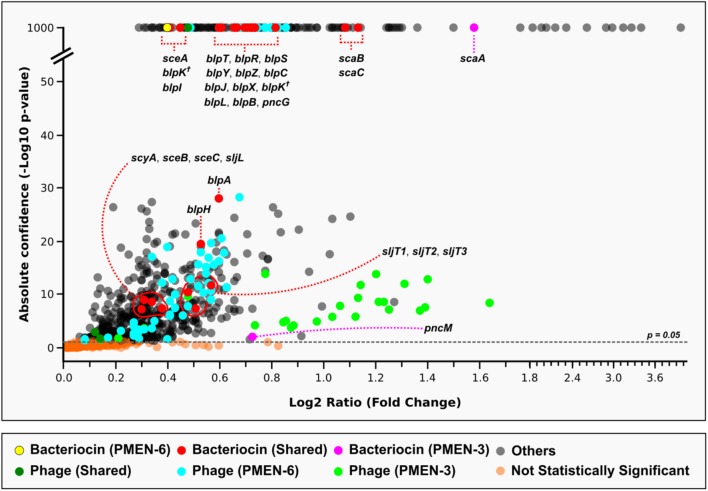
Evidence for the upregulation of bacteriocin genes when two reference strains, PMEN-3 and PMEN-6, were co-cultured in broth media. Only genes that were significantly upregulated compared to the controls (strains cultured individually) are shown in the figure. Genes of interest that were unique to each reference strain and those shared by both strains are marked in different colors. Two copies of blpK were found in different locations (one in the blp cluster as expected and one elsewhere in the genome) in both genomes and are marked here with a cross. A full list of the genes depicted here and their sequences is found in the Supplementary Table S5.